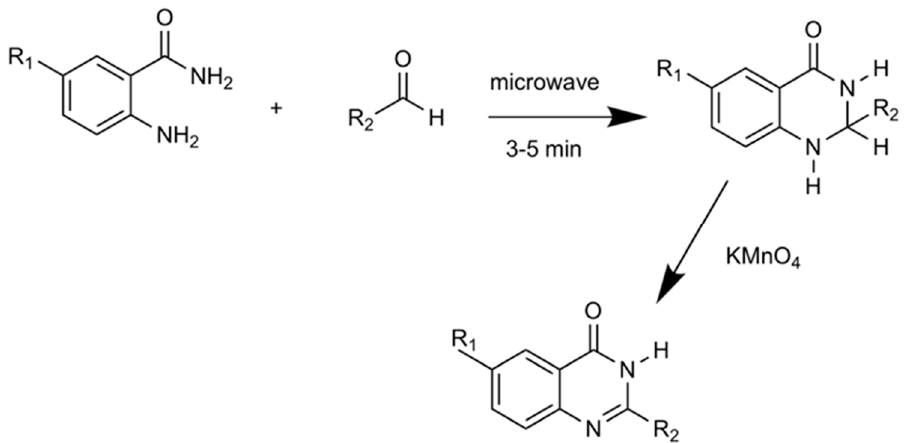
Molecules 2023 , 28 , x FOR PEER REVIEW 6 of 25 Scheme 9 . Synthesis of 2,3 disubstituted 4(3 H )-quinazolinone by condensation of N-acylanthranillic acids with primary amines